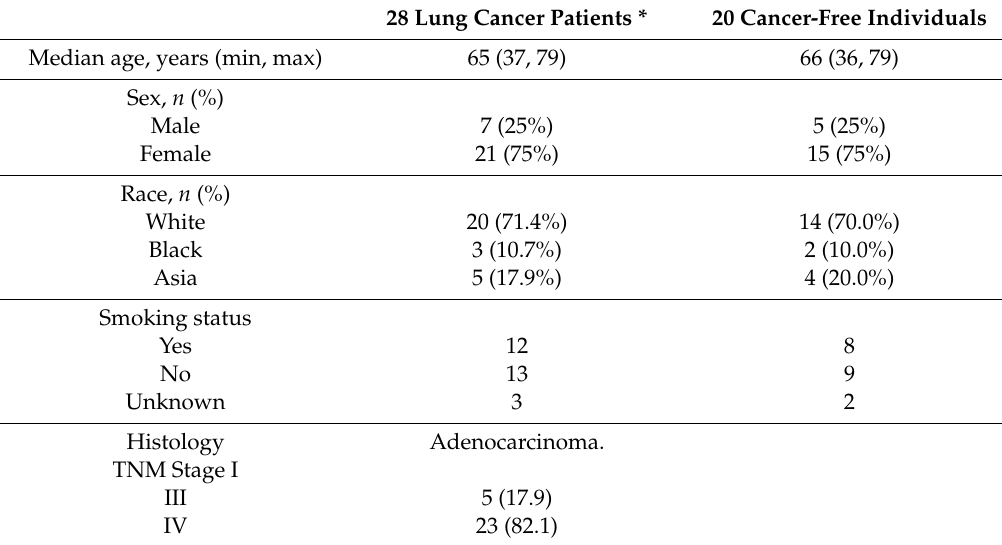
Table 4. Demographics and diagnostic characteristics of 28 lung cancer patients and 20 cancer-free individuals. 28 Lung Cancer Patients * 20 Cancer-Free Individuals